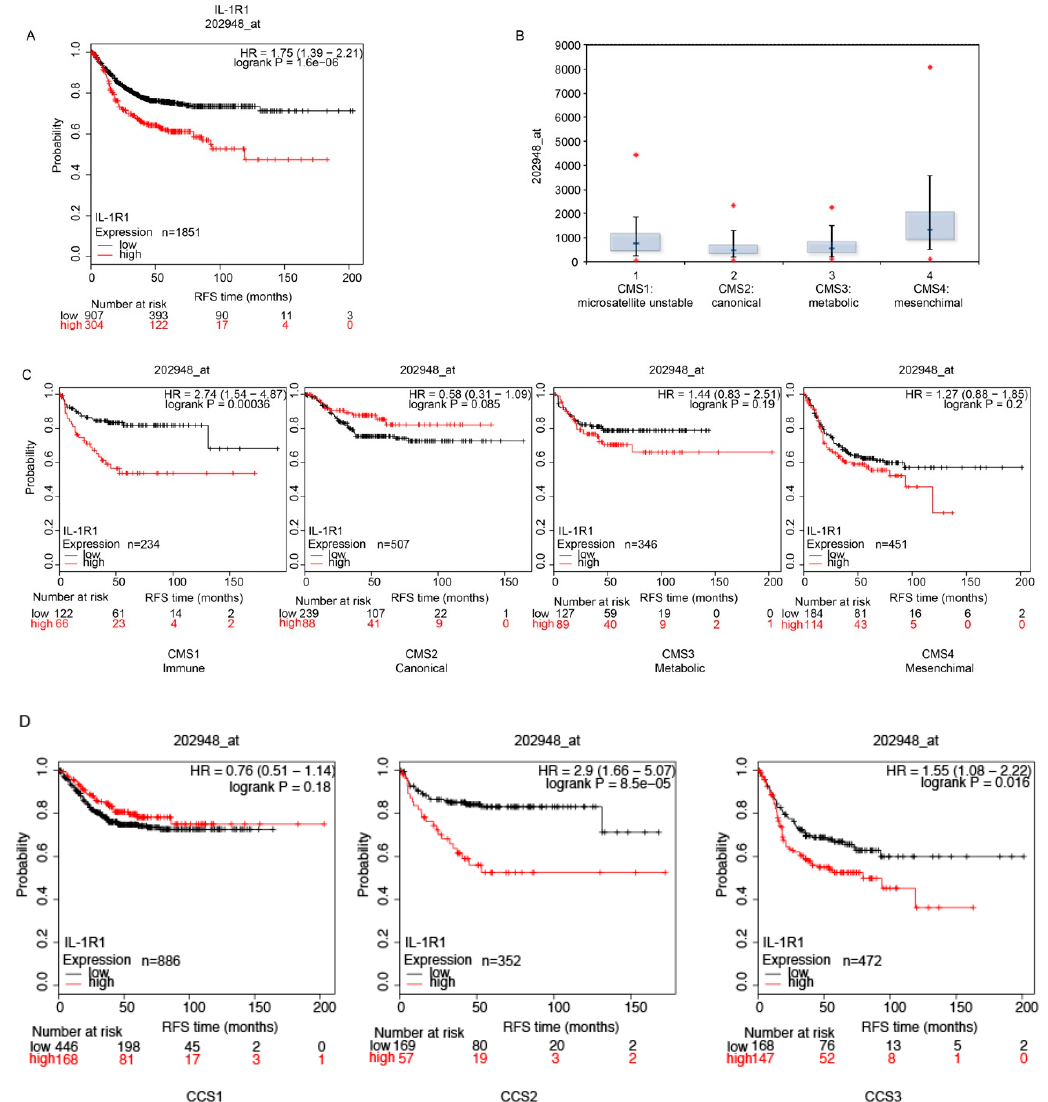
Figure 5. IL-1 receptor expression predicts survival in CRC patients. ( A ) A cohort of 1211 patients was divided into two groups according to IL-1 receptor abundance. In the Kaplan-Meier plot, the black line represents patients with an overall low IL-1R1 expression, while the red line represents subjects with high expression of IL-1R1. For each patient, the relapse free survival (RFS) is reported over time and expressed in months. ( B ) mRNA abundance of IL-1R1 in the four consensus molecular subtypes (CMSs). ( C ) Stratification of patients using the CMS criterion. Patients are divided into four subtypes. CMS1 (Immune): hypermutated, microsatellite unstable and strong immune activation. CMS2 (Canonical): epithelial, marked WNT and MYC signaling activation. CMS3 (Metabolic): epithelial and evident metabolic dysregulation. CMS4 (Mesenchymal): prominent transforming growth factor-b activation, stromal invasion and angiogenesis. ( D ) KM plot of IL-1 receptor expression using the de Sousa Classification of Colon Cancer subtypes.